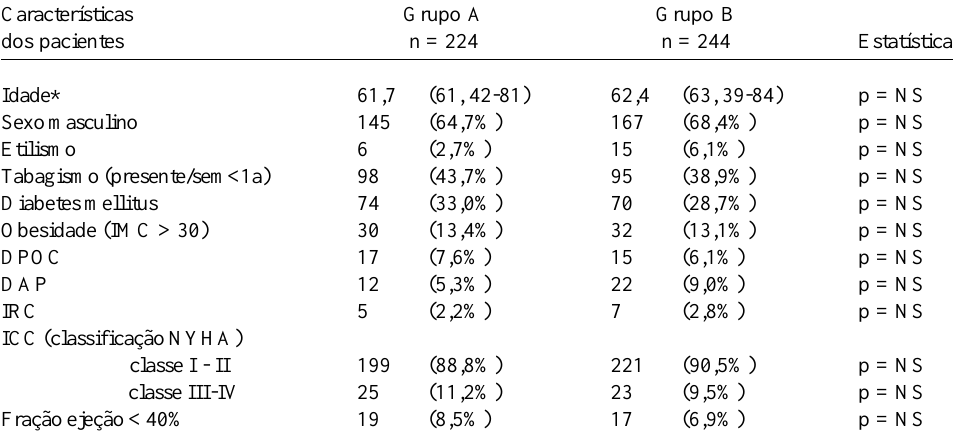
Tabela 1. Características dos pacientes em cada grupo.